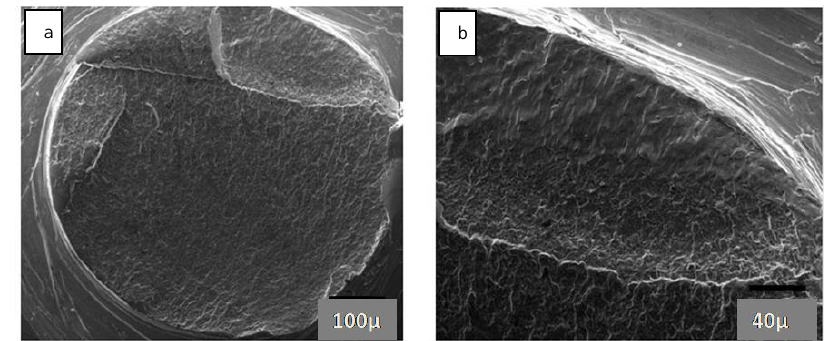
Fig 7. Scanning electron fractograph of the retrieved implant 4.